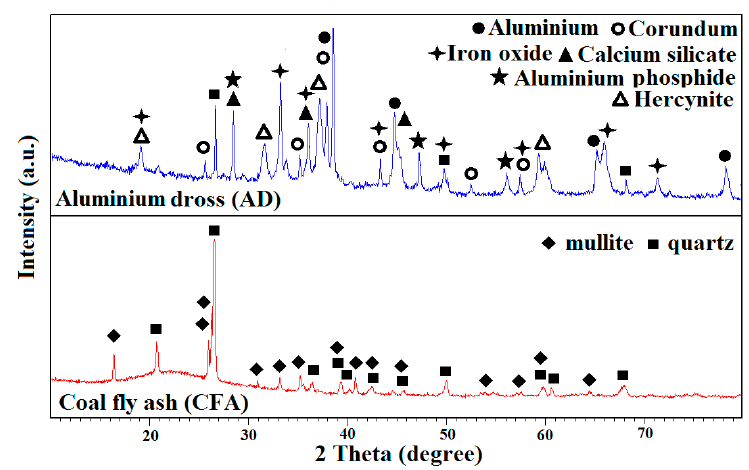
Figure 2. XRD patterns showing the crystalline phase identification of two starting materials: (top) aluminum dross, AD and (bottom) coal fly ash, CFA.